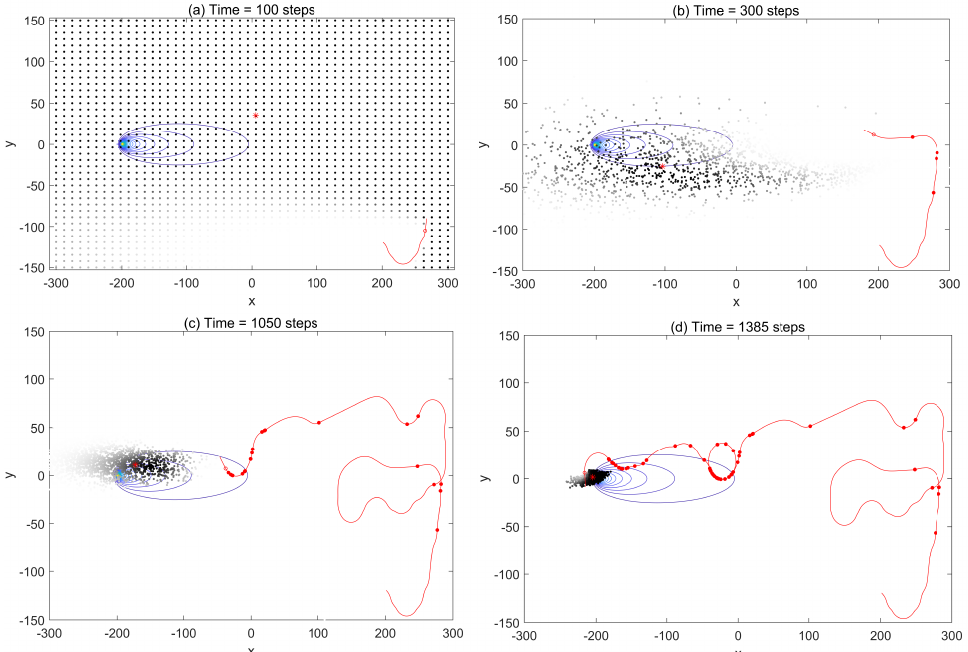
Figure 1. The trajectory (red line), detections (red solid circles), and particles (black dots) of the mobile sensor platform at the times k = 300, 500, 1080, 1385 using the infotaxis scheme. The source location at ( − 200,0 ) with the contour plot of the corresponding mean rate. The estimated source is indicated by the weighted center of the particles marked by the red